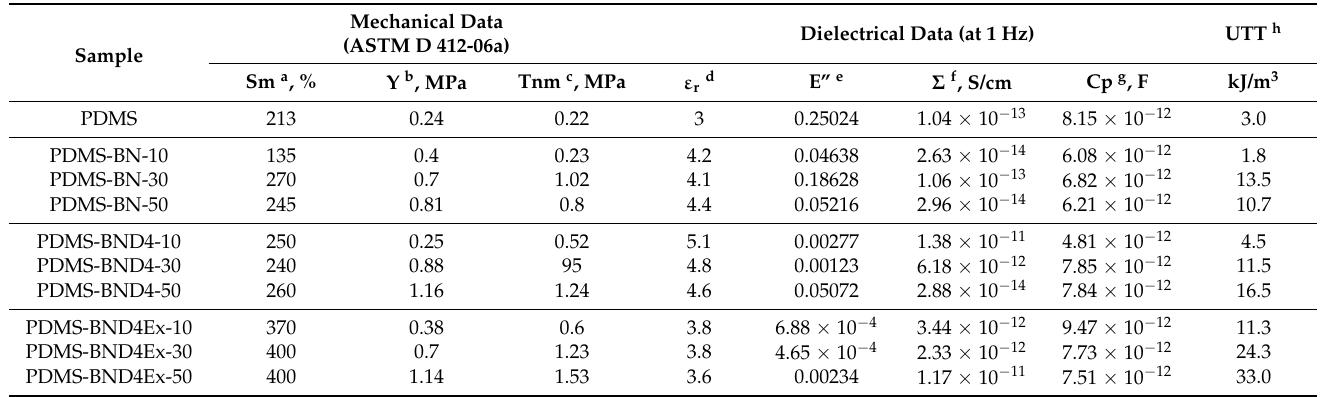
Figure 8. Stress – strain curves for the three composite series: ( a ) — with the pristine BN powder; ( b ) — with BN treated with D4; ( c ) — with BN treated with D4 and exfoliated. Table 2. The main mechanical and dielectric parameters estimated based on stress–strain curves and dielectric spectra.